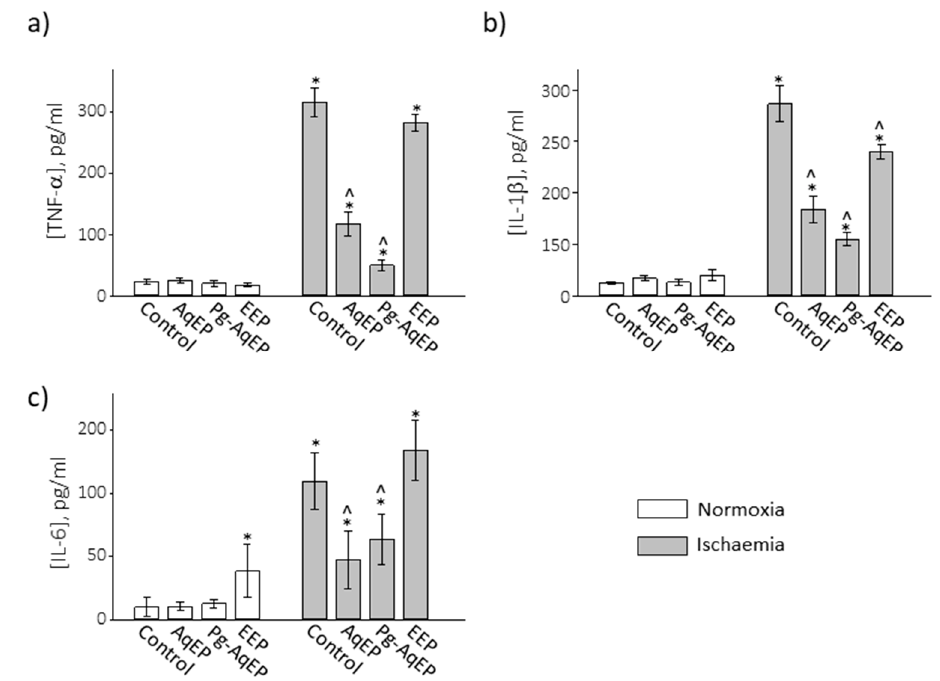
Figure 6. Concentration of proinflammatory cytokines TNF- α ( a ), IL-1 β ( b ) and IL-6 ( c ) in a medium of cultured primary cerebellar neuronal-glial cells after simulated ischaemia (hypoxia plus DOG) treatment. The data are presented as the average ± SE of 3 experimental repeats performed in quintuplicate. *—statistically significant difference compared to the normoxic control, p < 0.05; ^— statistically significant difference compared to the hypoxic control, p < 0.05.